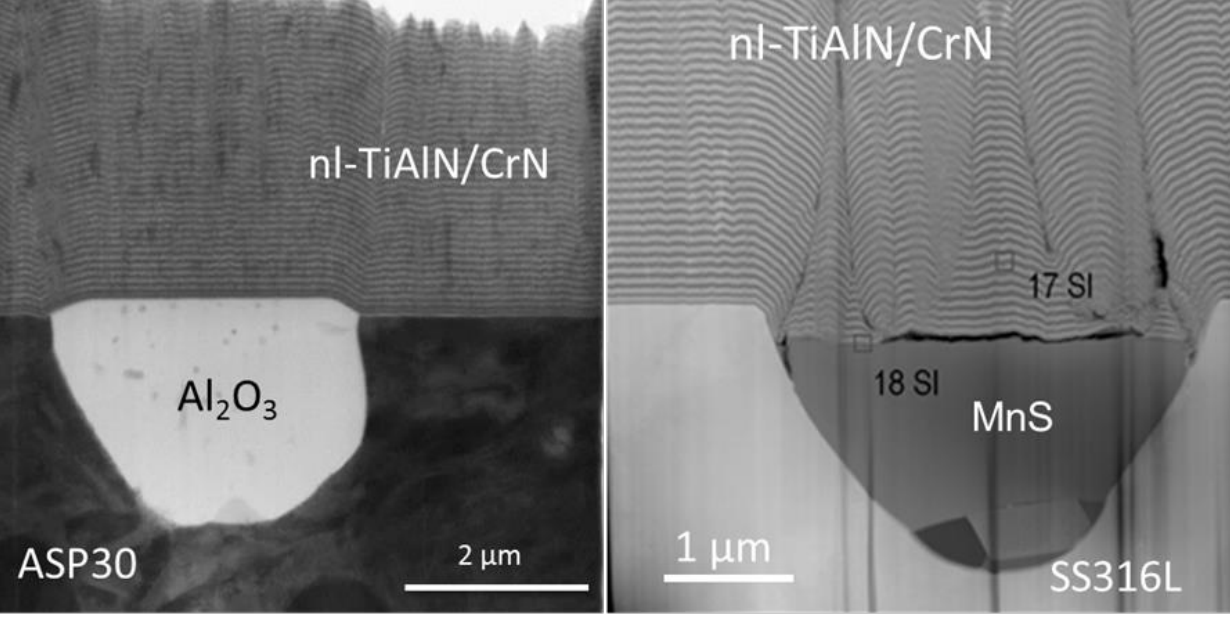
Figure 14. STEM image of FIB cross-section of the nanolayered TiAlN/CrN hard coating at sites of Al 2 O 3 (ASP30 substrate) and MnS (SS316L substrate) nonmetallic inclusions.